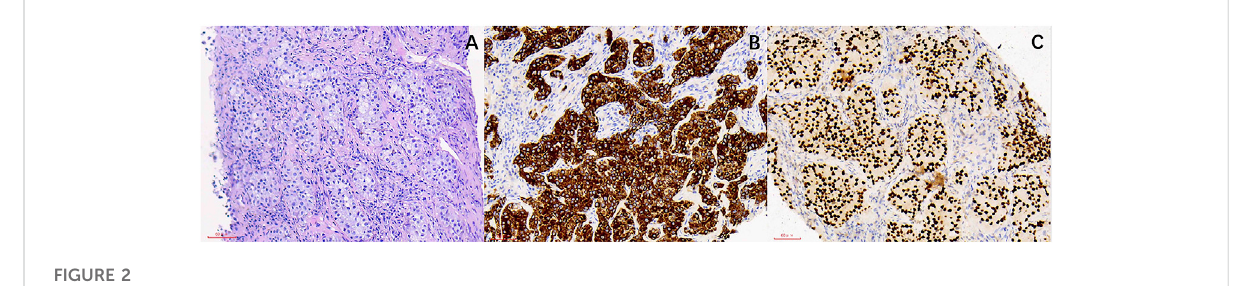
FIGURE 2 The HE staining and IHC images from lung cancer patients with liver metastasis. (A) Lung cancer (HE ×200). (B) CK7(+) (SP ×200). (C) TTF-1 (+) (SP ×200).